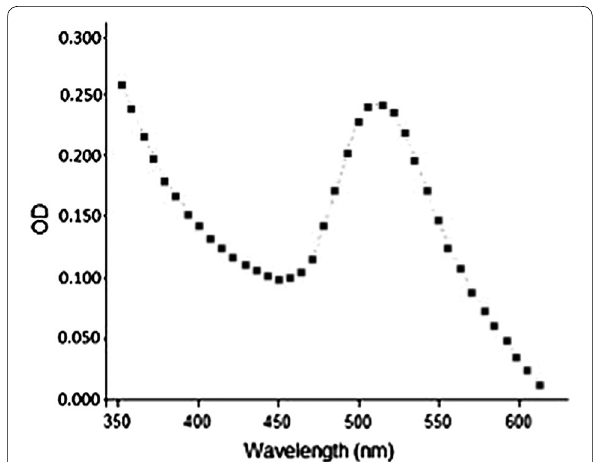
Fig. 2 Visible spectrophotometer results of GNPs after 1:5 dilutions with SDB. The maximum absorbance peak around 525 nm is the sign of the presence of GNPs